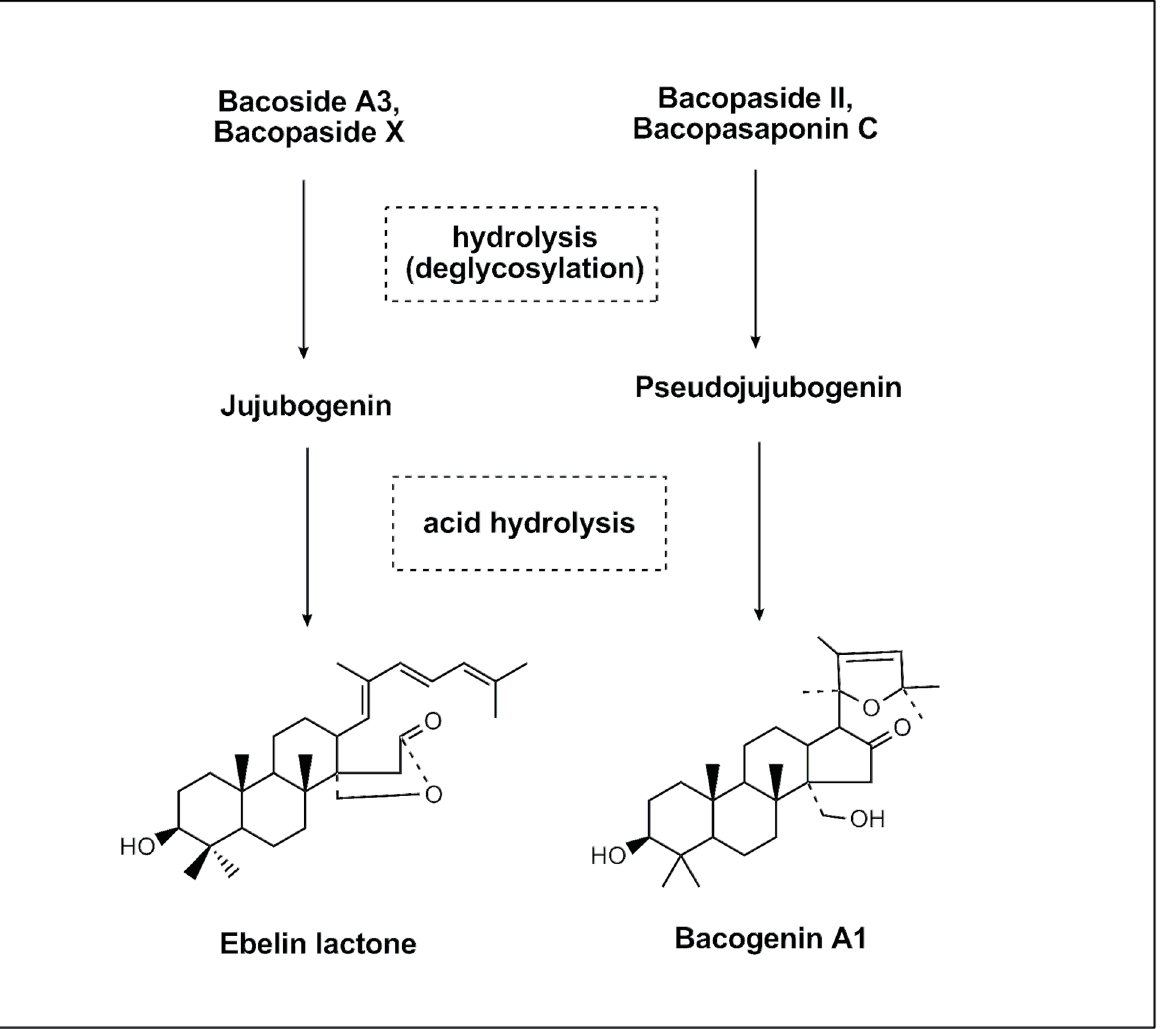
Fig 2. Formation of ebelin lactone and bacogenin A1. Bacoside A components form aglycone jujubogenin and pseudojujubogenin through deglycosylation and further acid hydrolysis yields ebelin lactone and bacogenin A1.